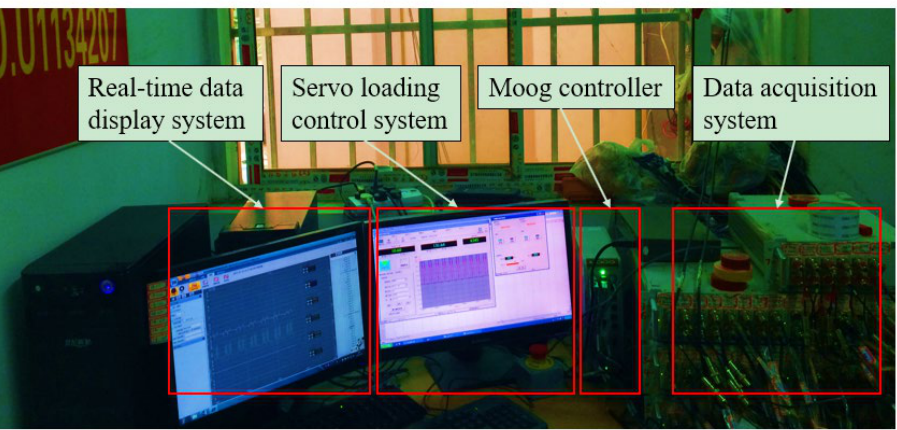
Figure 6. Dynamic loading hydraulic servo control and digital data acquisition system.